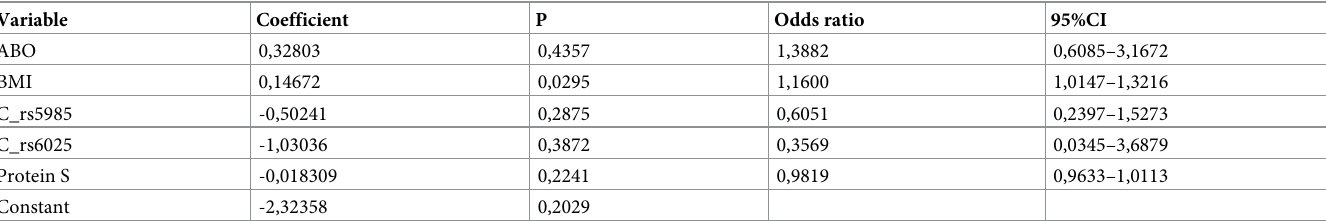
Similar to our results, other studies failed to confirm an association between inherited thrombophilias and adverse obstetric outcomes [30–32], and only weak associations have been found between hypercoagulability and pregnancy outcomes. The lack of association is likely attributable to the multifactorial nature of adverse obstetric outcomes, involving the interac- tion of epidemiological, clinical, and genetic risk factors. Outcomes do not appear to be solely caused by genetic factors; these factors are common in the general population and do not lead to adverse outcomes in the absence of other risk factors. Table 4. Components of a clinical-genetic model for predicting adverse obstetric